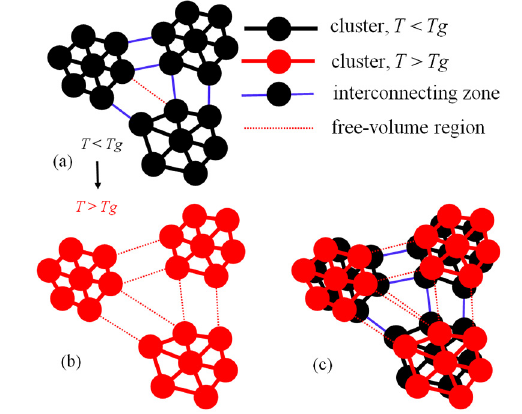
Figure 12. Tight-bond cluster model: A change in the connections between clusters below and above T ). above T g